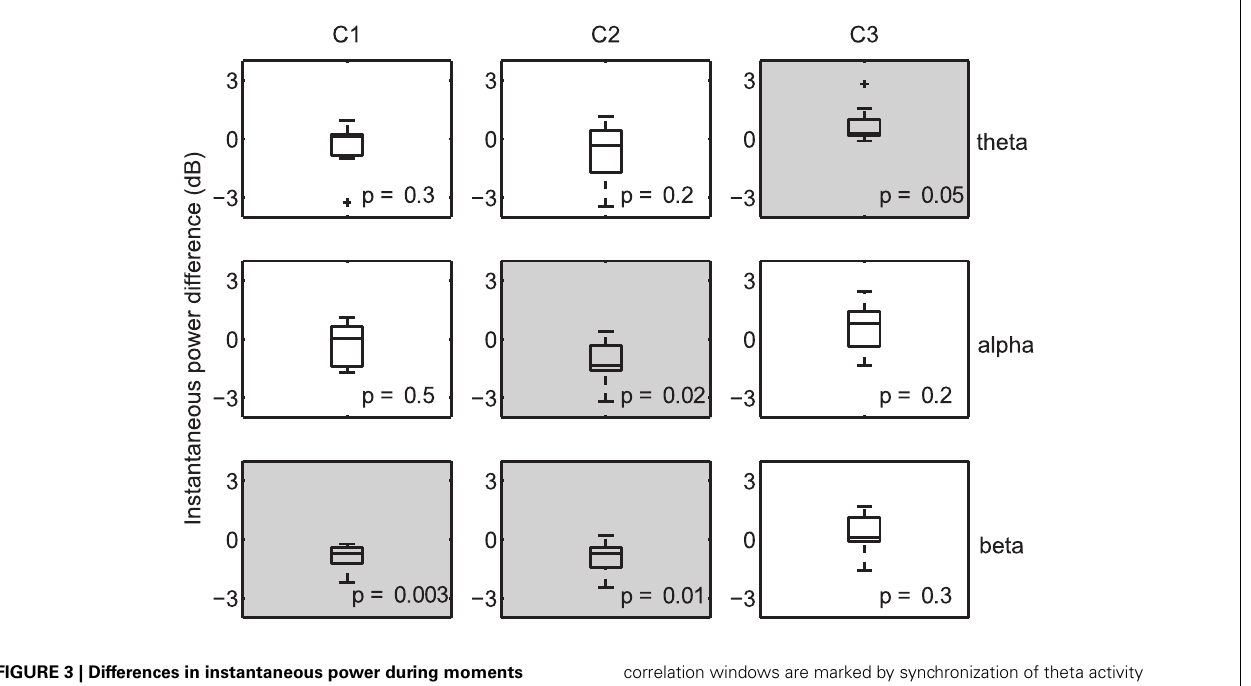
FIGURE 3 | Differences in instantaneous power during moments of high versus low neural correlation. Distributions are constructed along the subject dimension ( n = 10, with statistically significant effects denoted with a light gray background). High